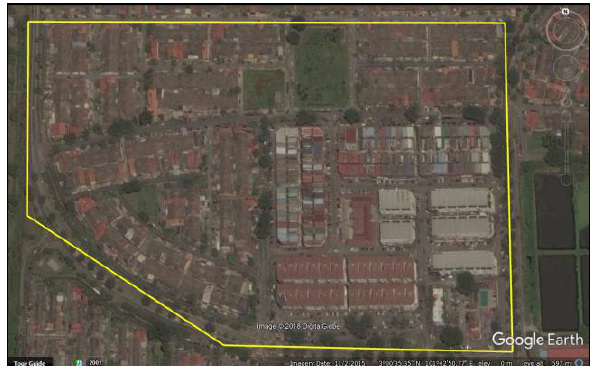
Figure 1: Study area at Taman Sri Serdang (Google Earth,